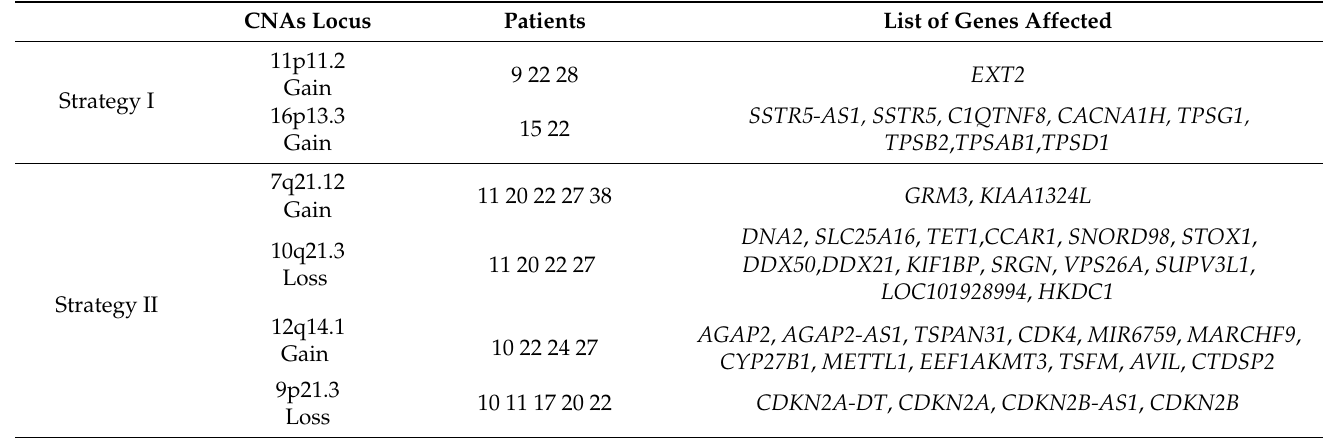
Table 3. Selection of copy number alterations (CNAs) by the two applied strategies (I and II). Associ- ated patients in whom they are found and the list of genes affected by each imbalance are reported.